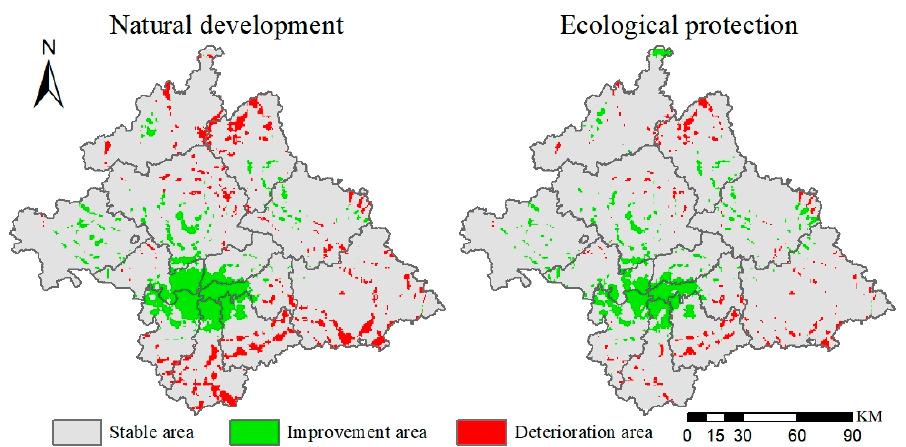
Figure 10. Changes in ecological risk in Nanning under different scenarios from 2018 to 2036.